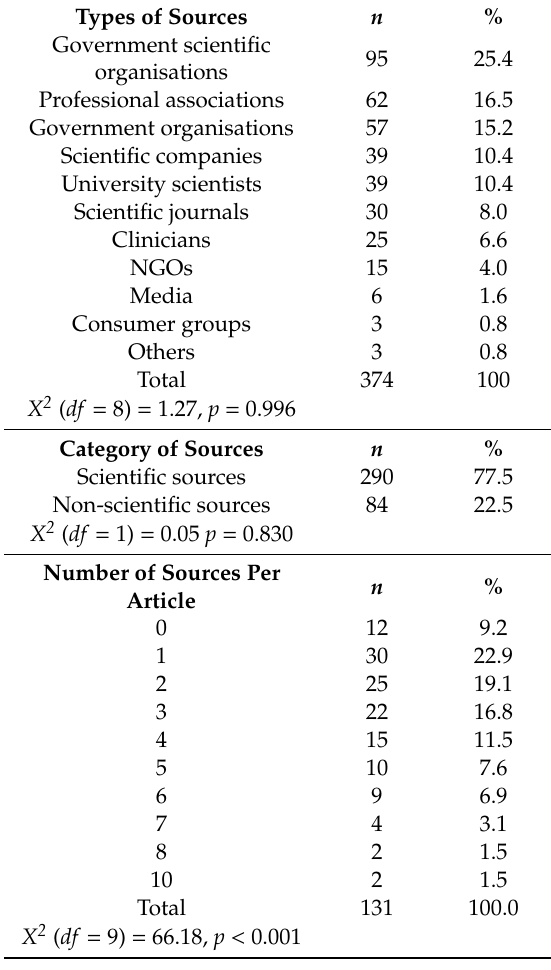
Table 2. Frequency counts for